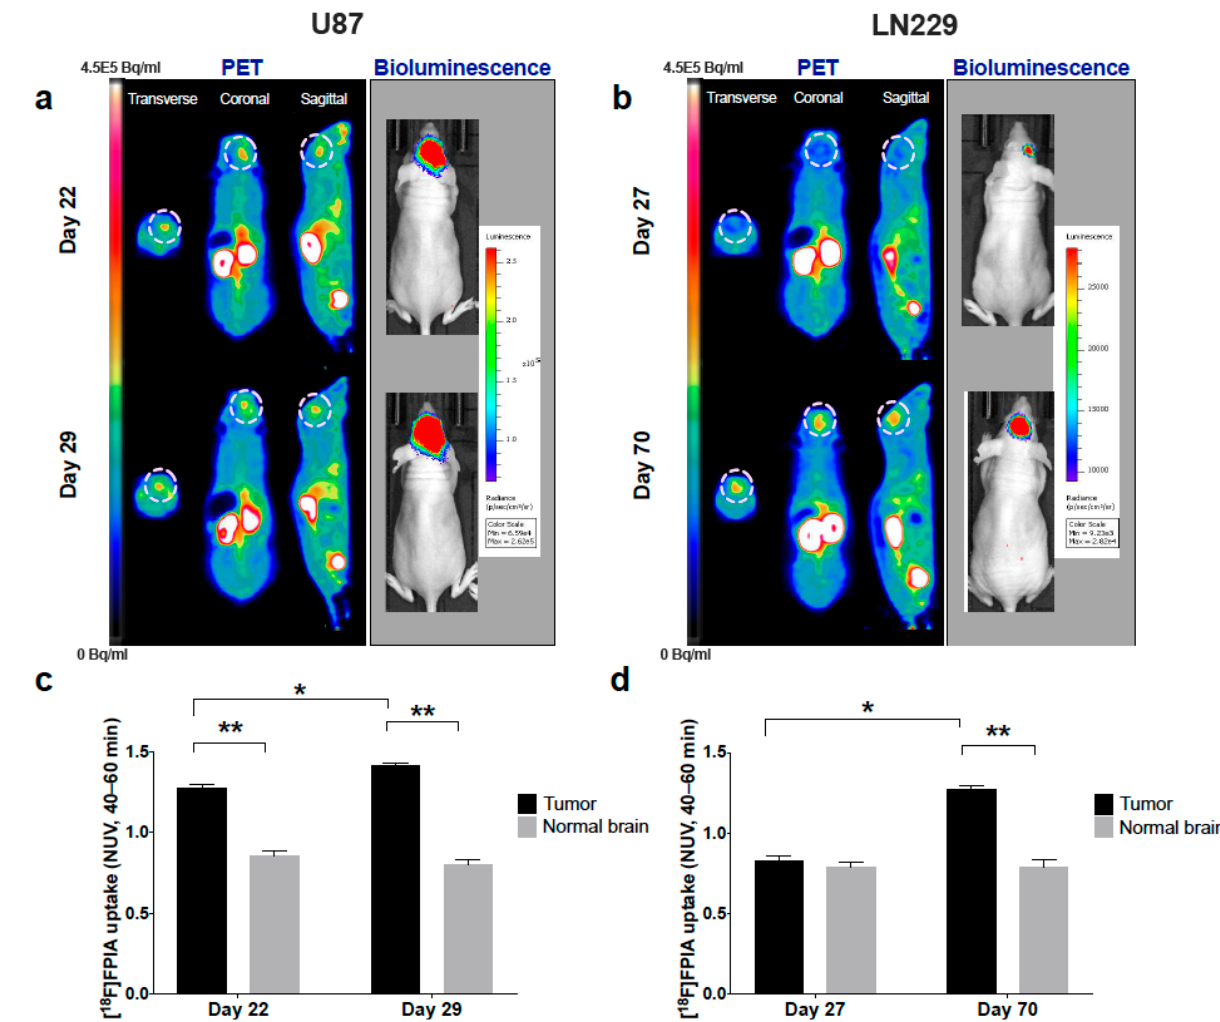
Figure 2. [ 18 F]FPIA PET imaging of orthotopic glioma xenograft growth. Tumor models were generated using U87 and LN229 glioma cells, and mice underwent [ 18 F]FPIA PET and bioluminescence imaging twice post-tumor cell implantation. Representative PET and bioluminescence images of ( a ) U87 and ( b ) LN229 tumors over time. Tumor and normal brain uptake of [ 18 F]FPIA (NUVs, 40–60 min) in ( c ) U87 and ( d ) LN229 tumors. 18 [F]FPIA tumor uptake significantly increased over time for U87 and LN229 tumors (* p = 0.001, p < 0.0001, respectively, 2-way ANOVA). Significantly higher [ 18 F]FPIA uptake was observed in U87 tumor lesions compared to normal brain for both scans (** p < 0.0001, 2-way ANOVA), and at day 70 in LN229 tumors (** p < 0.0001, 2-way